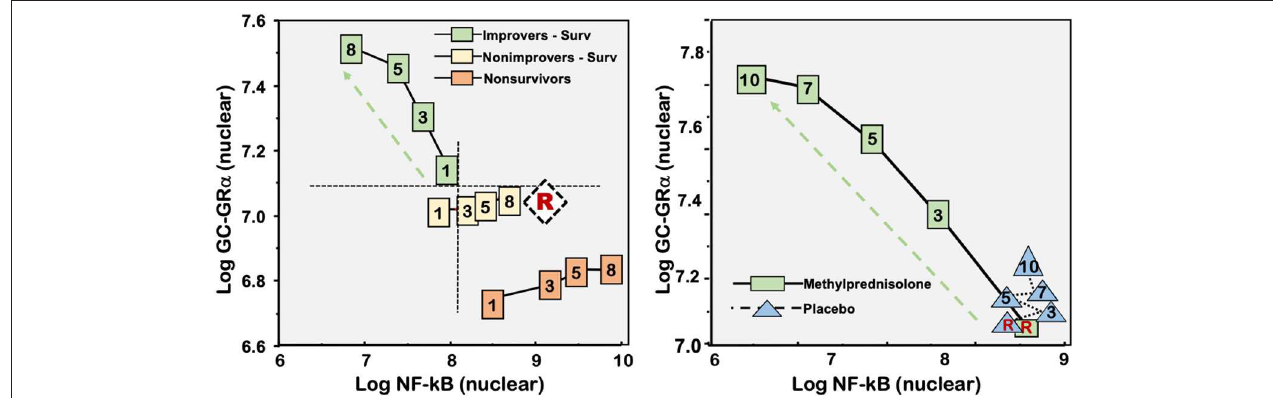
FIGURE 4 | Correlation between mean levels of nuclear NF- κ B and nuclear GC-GR α during the natural progression of ARDS, and in response to prolonged glucocorticoid treatment. Mean intracellular changes of nuclear GC-activated GR α and NF- κ B observed by exposing PBLs of a healthy volunteer to plasma samples collected longitudinally (days 1, 3, 5, and 8) and after randomization to methylprednisolone treatment [randomization day (R) and post-randomization days 3, 5, 7, and 10]. The mean values of nuclear NF- κ B are plotted against the mean nuclear GC-GR α levels. Improvers had a pre-defined improvement in lung injury score (139) and/or gas exchange component by day 7. The left panel shows ARDS patients with adaptive and maladaptive responses. In improvers, an inverse relation was observed between these two transcription factors, with the longitudinal direction of the interaction shifting to the left (decreased NF- κ B) and upward (increased GC-GR α ). In contrast, in non-improvers NF- κ B increased over time while GC-GR α had no significant changes. We define the first interaction as GC-GR α -driven, and the second interaction as NF- κ B-driven ( 33). The right panel shows non-improvers-survivors randomized after day 8 of ARDS to methylprednisolone ( n = 11) vs. placebo ( n = 6). After natural logarithmic transformation and adjustment for repeated measurements, partial correlations among responses to plasma from the methylprednisolone group were − 0.92 ( p < 0.0001) both for nuclear NF- κ B and nuclear GR α . For responses to plasma from the placebo group, no significant relation was found between nuclear NF- κ B and nuclear GR α ( r = 0.11; p = 0.70) ( 103). Reproduced with permission from Meduri et al.